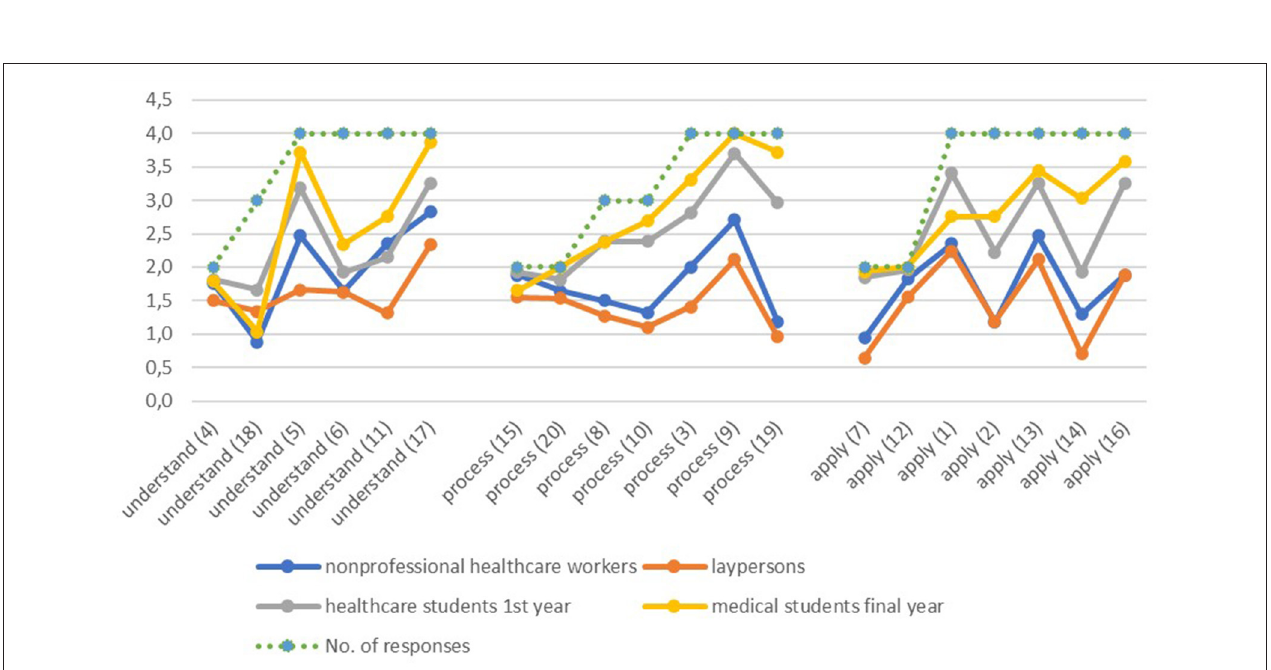
FIGURE 1 | Distribution of the corrected proportion of right answers by dimensions of health literacy by occupational groups. Green dots show the total number of responses (2, 3, or 4) on each item.